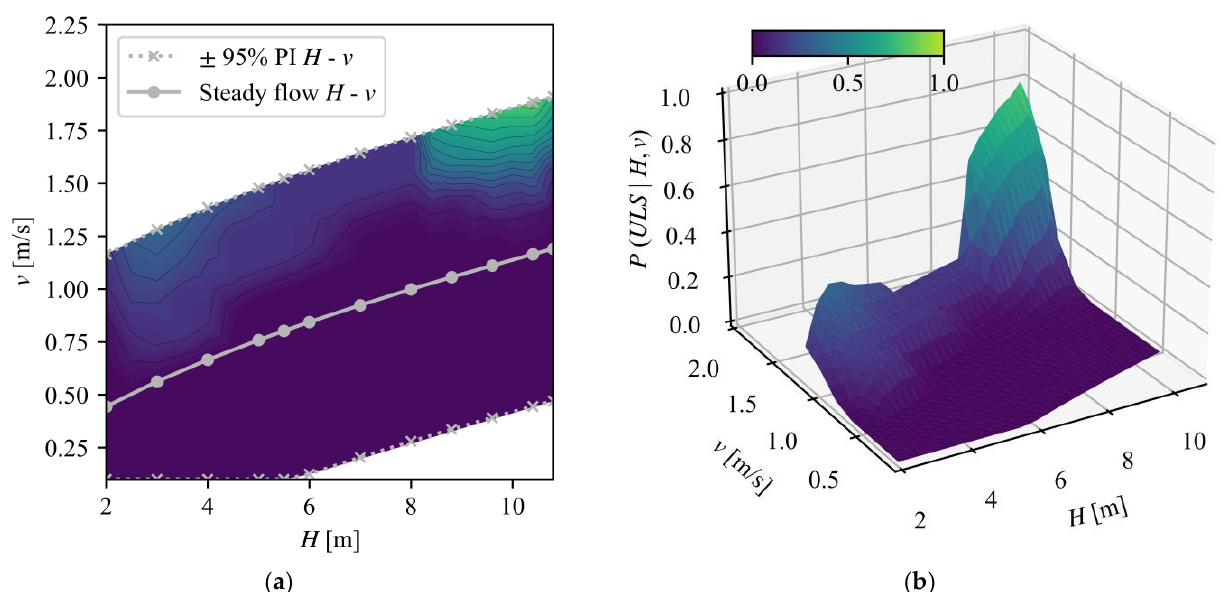
Figure 12. ( a ) Contour and ( b ) 3-D surface plot of the flood fragility surface for the ultimate limit state (ULS) for the second scenario (AS5100.2-2004 standard).